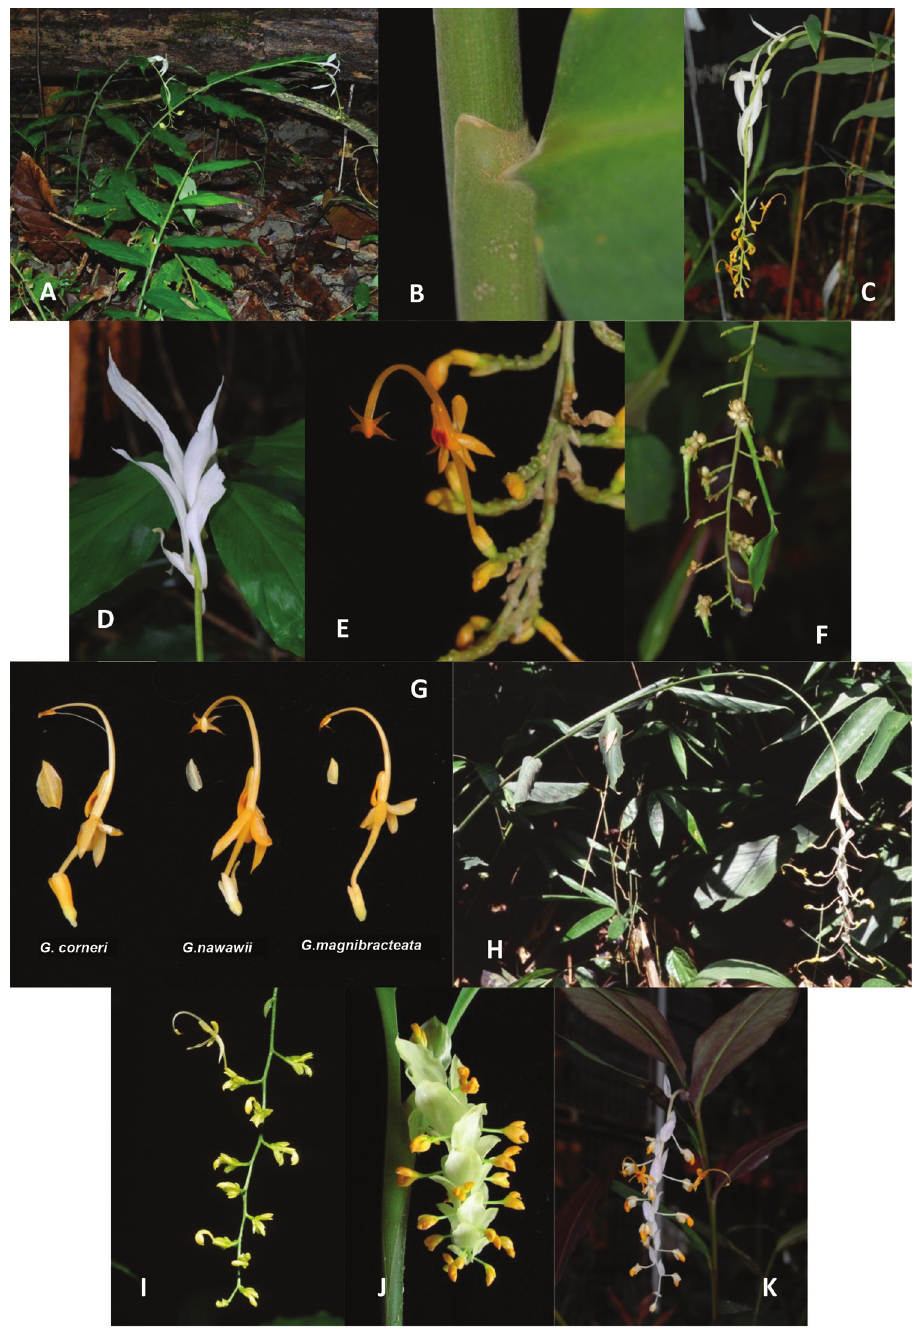
Figure 1. A–D Globba magnibracteata A Habit B Ligule C Inflorescence D Sterile floral bracts E Flower F Bulbils G Flowers of G . corneri , G . nawawii and G . magnibracteata H G . albobracteata I G . cernua J G . corneri K G . nawawii . (Photographs A–G, I and K by Y.Y. Sam, H by A. Takano, J by Y.M.